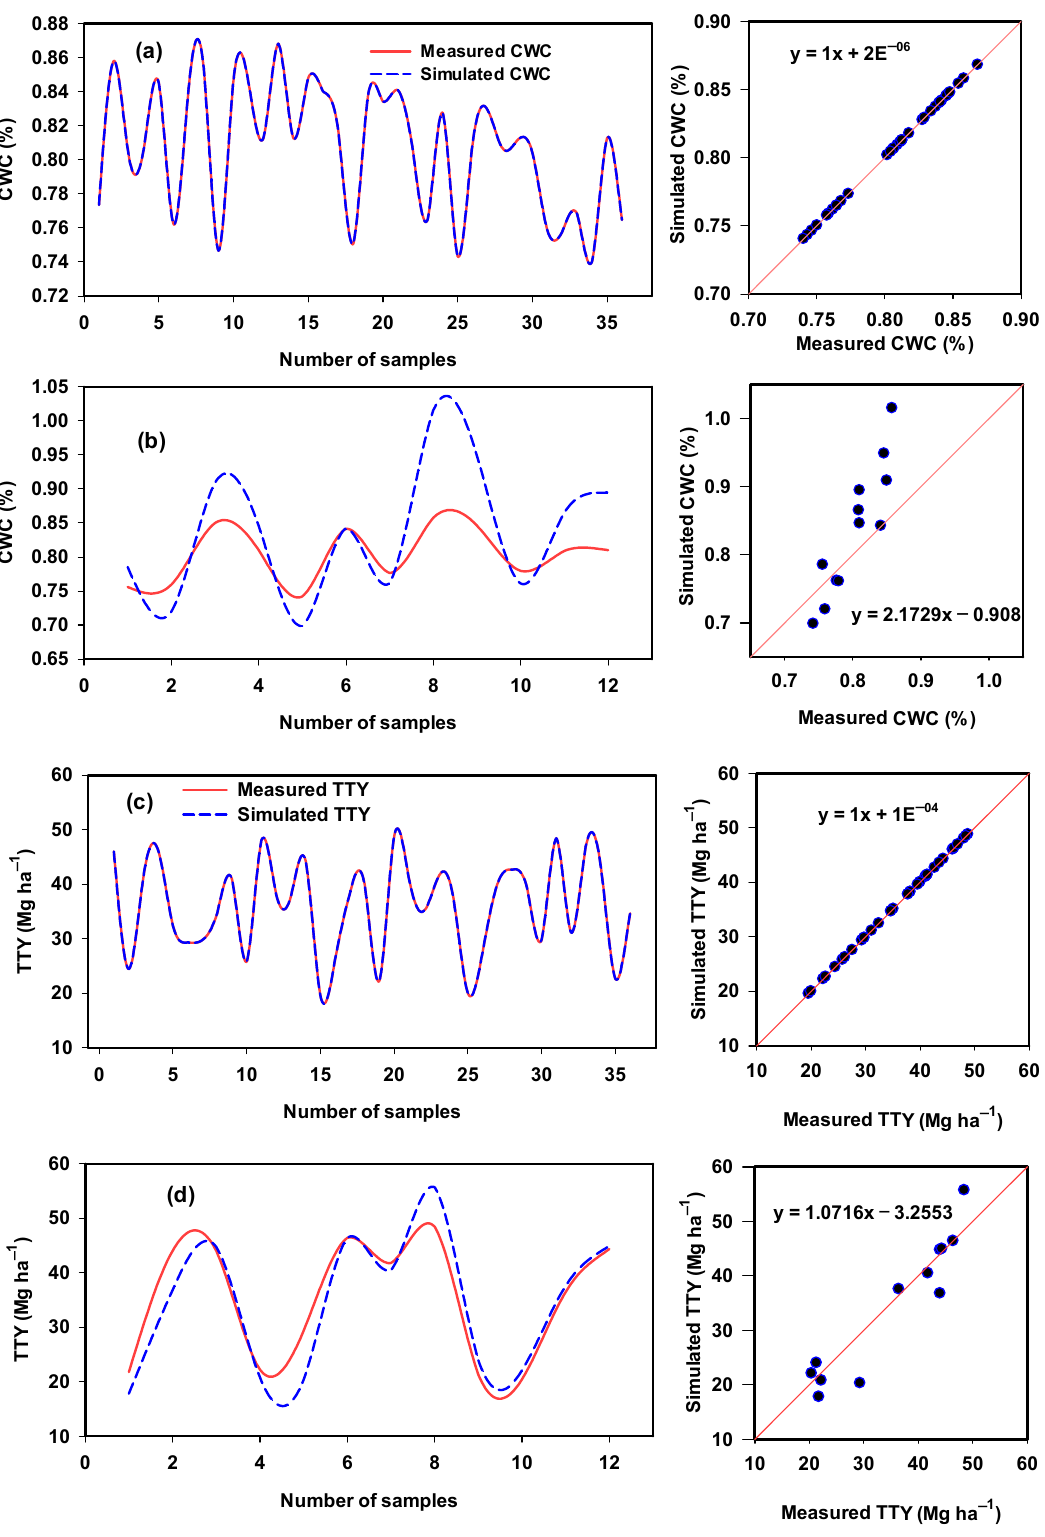
Figure 8. Comparison between training series ( a , c ) and testing series ( b , d ) for canopy water content ( CWC ) and total tuber yield ( TTY ) of two potato varieties using the developed ANFIS model.